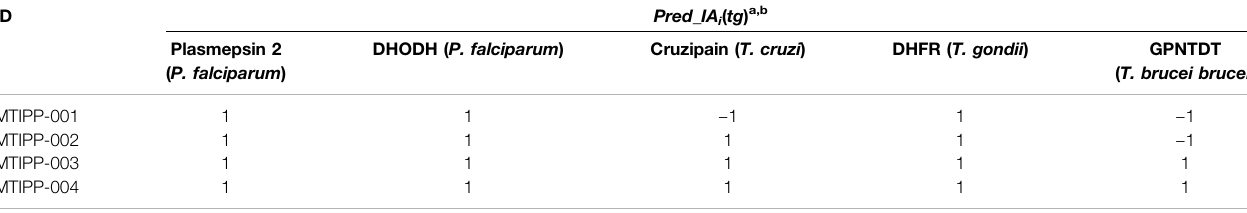
TABLE 4 | Molecules designed and the predictions of their multi-target pro fi les against the parasite proteins.